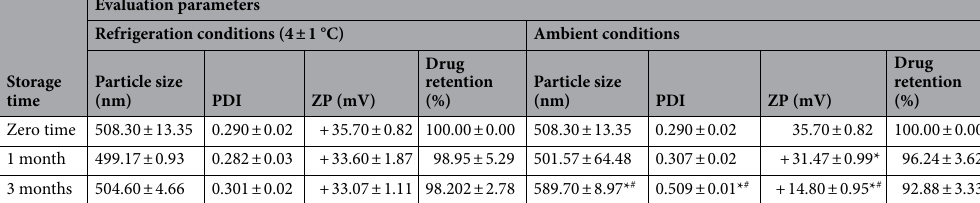
Table 4. Particle size, PDI, ZP and drug retention % of ALL-loaded CS/STPP NPs aqueous dispersions (F-9) stored at refrigeration (4 ± 1 °C) and ambient conditions (see Table 2 for F-9). Each value represents the mean ± SD (n = 3). *Significant at p < 0.05 monthly vs. initial. # Significant at p < 0.05 refrigeration vs. ambient conditions after 3